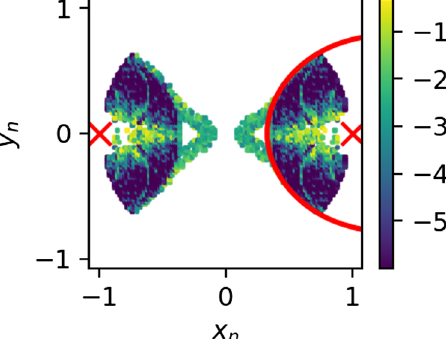
FIG. 24. Initial conditions of those particles whose time series data y has a dc frequency component larger than the dominant n nonzero frequency component when ν ¼ 0 . 36 and δμ ¼ 0 . 01 . The color map indicates Δ . FMA